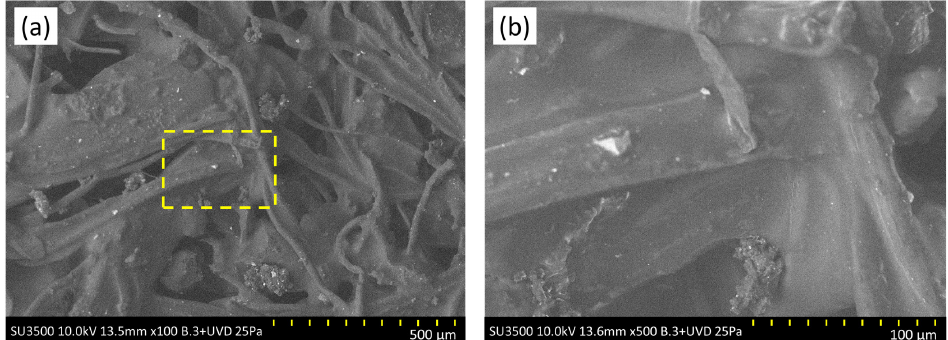
Figure 2. SEM images of the WTTF ‐ based additive used in this study: ( a ) 500 μ m; ( b ) 100 μ m.